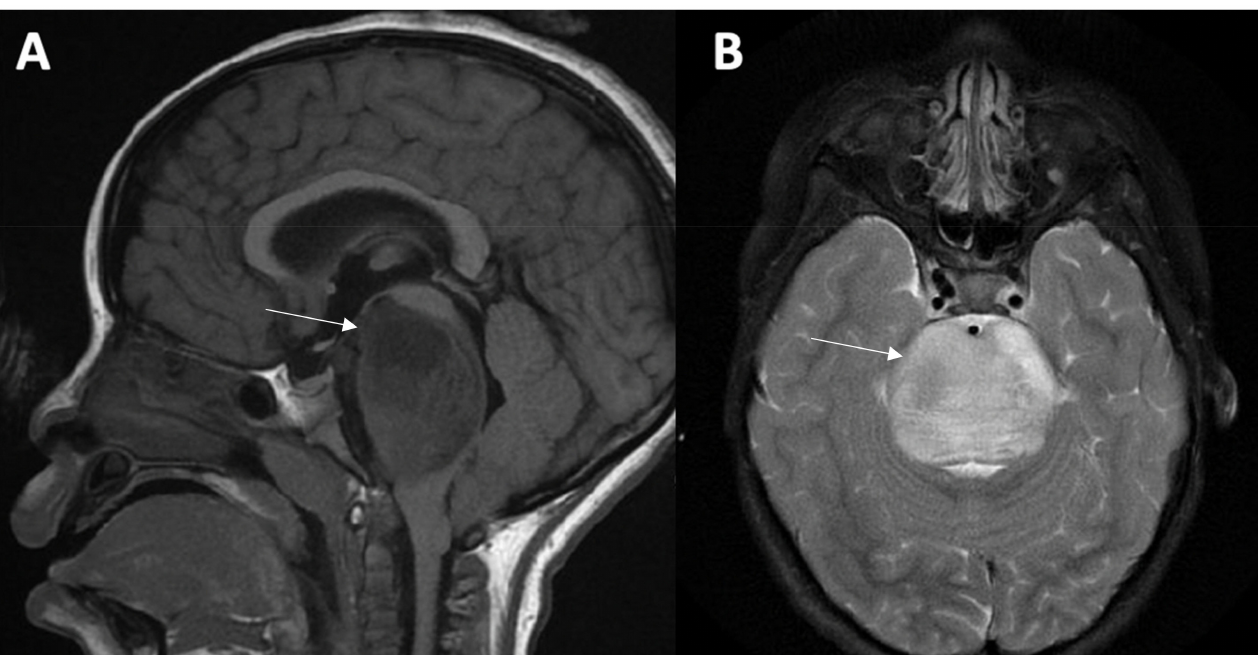
Figure 1. DIPG Imaging Findings. MRI of the brain with and without gadolinium in a child with an H3 K27 -altered, DIPG. The imaging demonstrates a sagittal T1 hypointense ( A ) and axial T2 hyperintense ( B ) lesion with homogeneous enhancement along with obstruction within the fourth ventricle of the brain occupying almost half of the axial